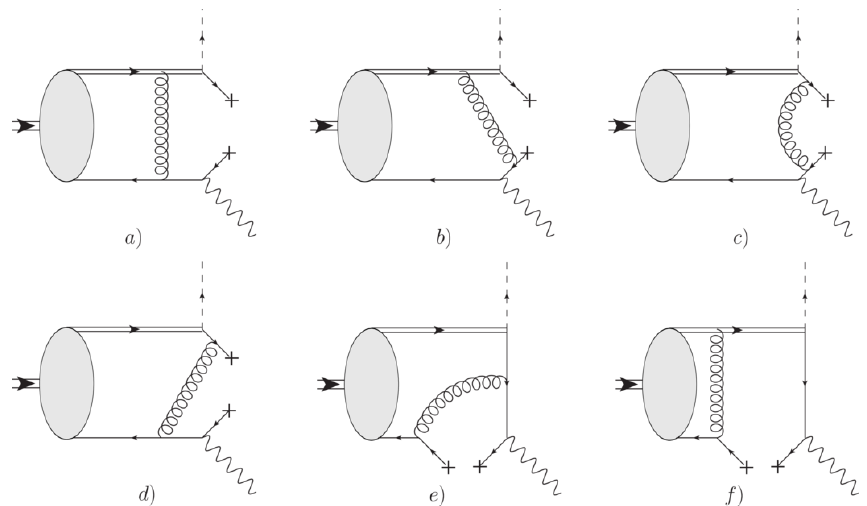
Figure 2 . Factorizable higher-twist corrections to B ! (cid:13)‘(cid:23) ‘